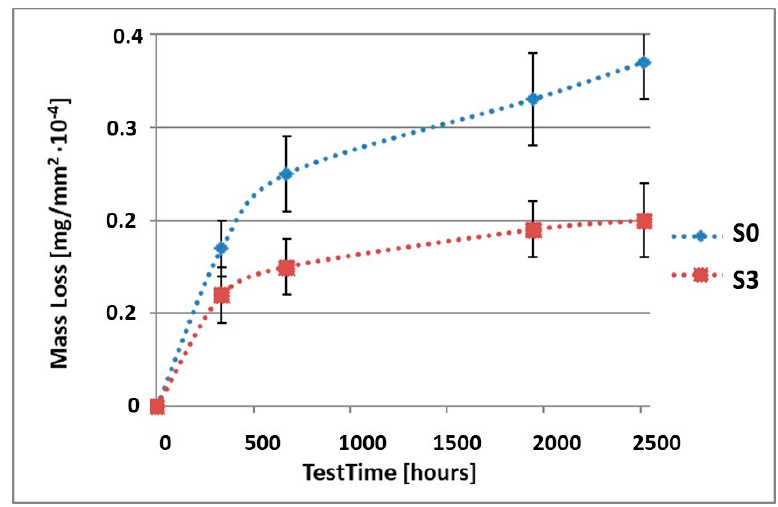
Figure 2. Comparison of the mass losses of samples S0 and S2 for tests in NSS environment.